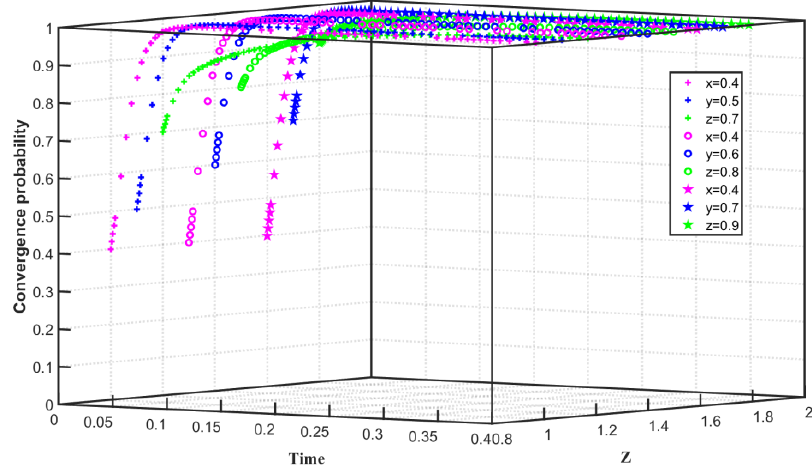
Figure 6. Evolution path of tripartite game system under low emission reduction cost and low reg- ulation cost. regulation cost.